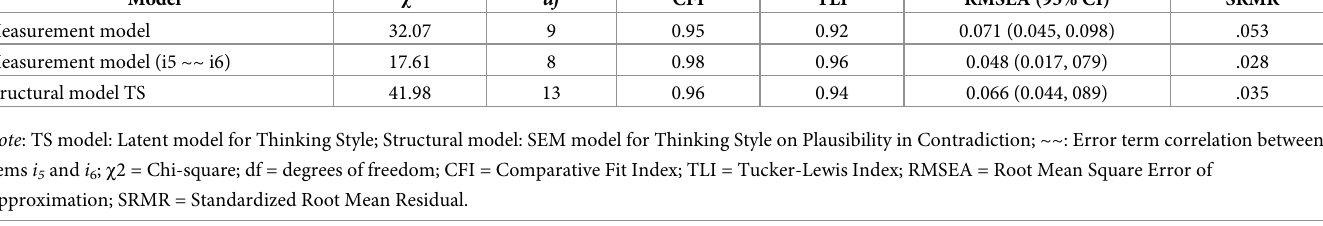
Table 2. Comparison of goodness-of-fit indices across models.